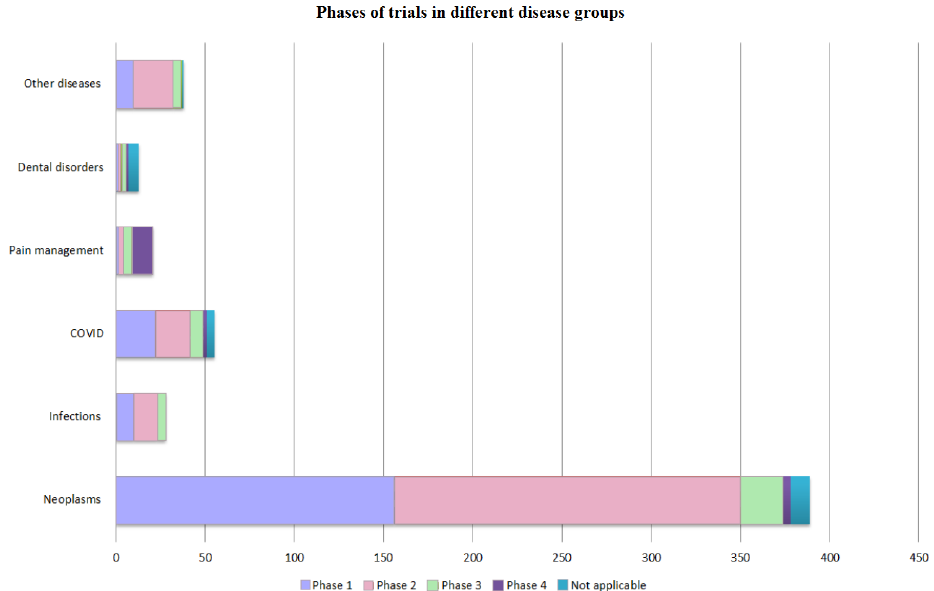
Figure 4. Phases of the trials in different disease groups. All studies since 2002 were categorized based on the diseases reported in the clinical trials. If several diseases were mentioned in the trial, then we divided them into separate groups of diseases. Further, each of the groups was divided based on the trials phases. The group other diseases consisted of neurological disorders, various cardiac conditions, diseases of the digestive system and rare genetic disorders. The most notable group was neoplasms which had almost 400 clinical trials. On the other hand, most of these trials were either in phase 1 or phase 2 (350 trials for both phases). The next three disease groups that also stood out were the pain management group, infections and dental disorders. In comparison to neoplasms, the number of clinical trials in these groups was very small (not more than 50 trials in each group). However, the pain management group had the biggest amount of trials that reached phase 4 (phase 4 accounted for almost half of all trials in the pain management group).